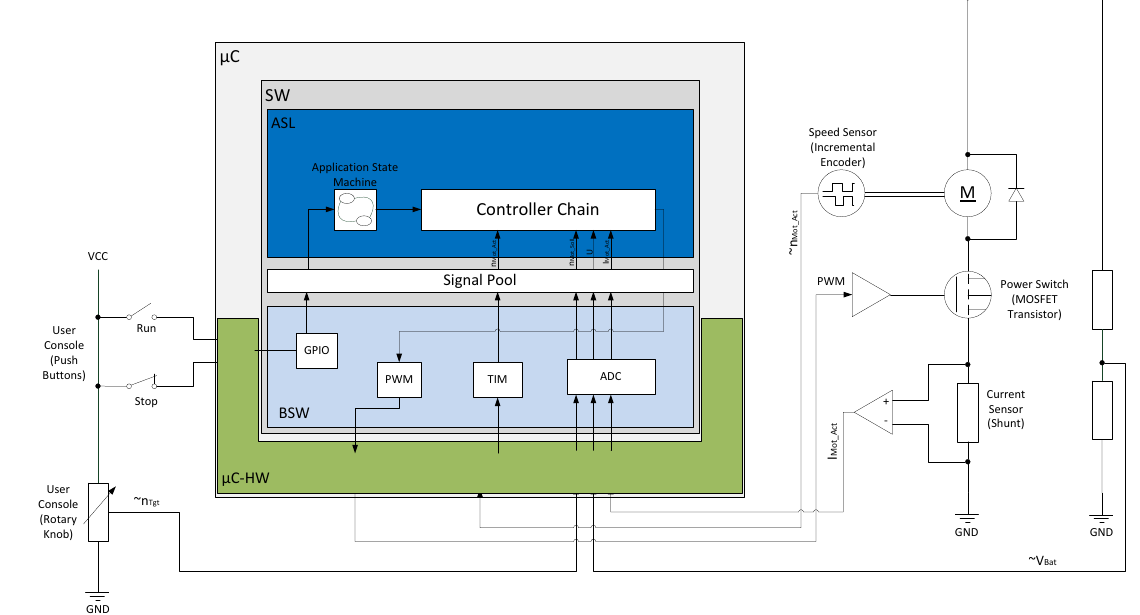
Figure 7. Technical overview of a simple DC Drive